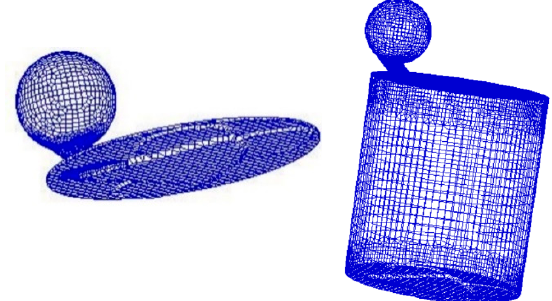
Figure 4. Modeling the mesh of sloping surfaces on top of the piston head.